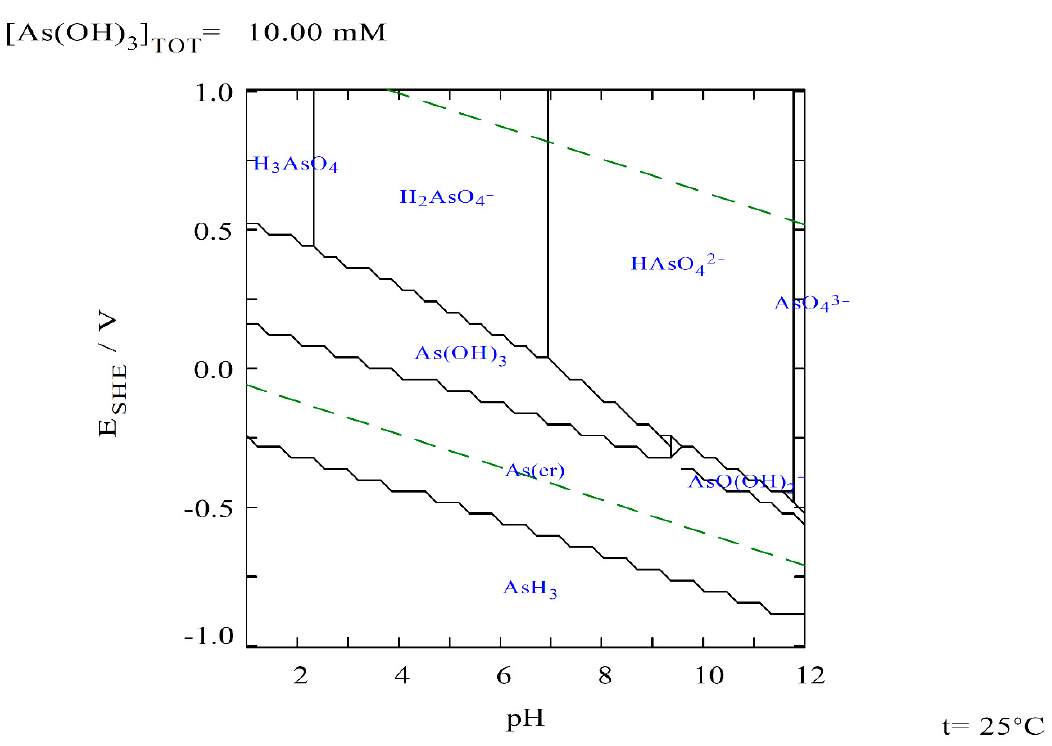
Figure 5. Arsenic predominance diagram at 25 ◦ C produced with the Hydra / Medusa software Figure 4. Arsenic predominance diagram at 25 °C produced with the Hydra/Medusa software [31].